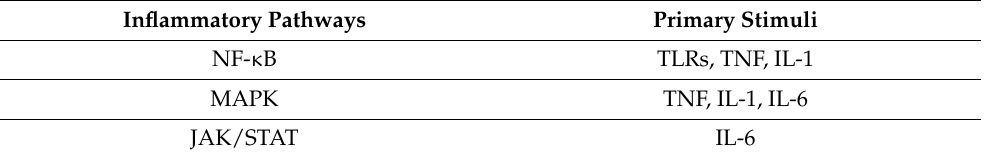
Table 5. Intracellular inflammatory signaling